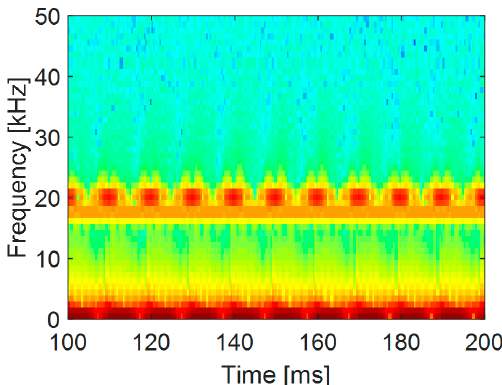
Figure 7. Case study 2: Time-frequency representation obtained by means the spectrogram with 1 kHz frequency resolution and 1 ms time resolution.